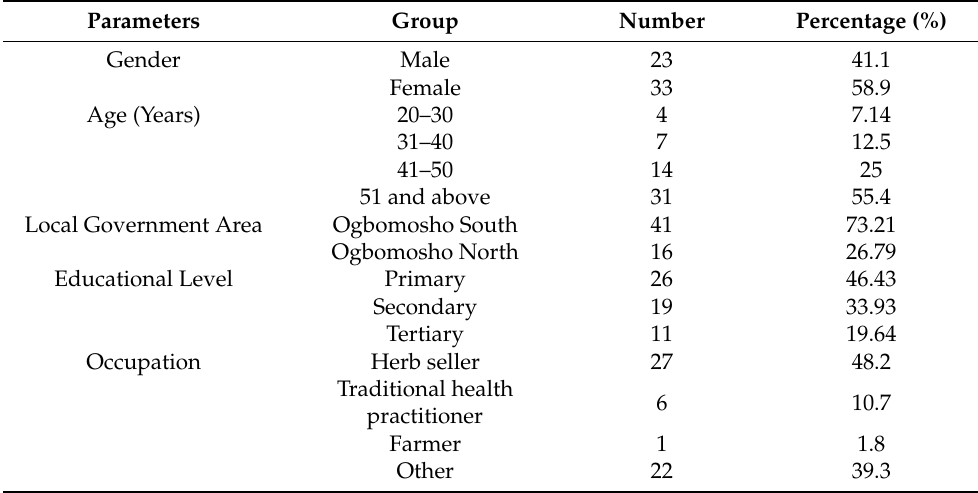
Table 1. Demographic information of participants (n = 56) in the study